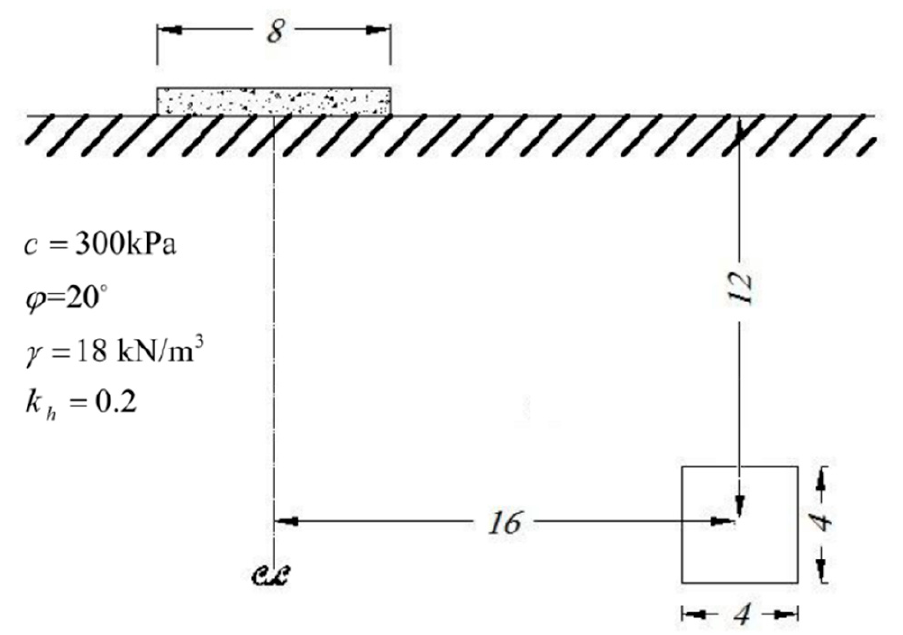
Figure 17. Geometry of the case study (measures in m).